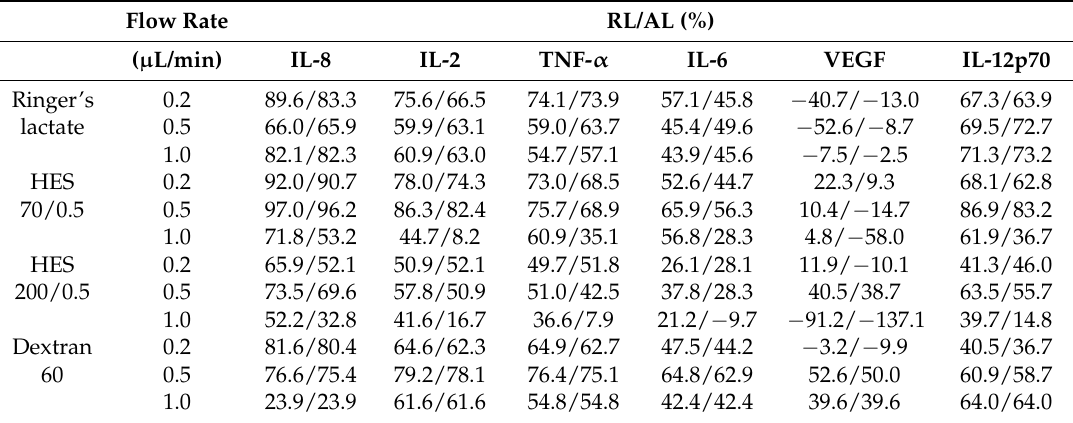
Table 2. Relative loss (left column) and Absolute loss (right column) from retrodialysis in anaesthetised domestic pigs in vivo (pooled data from two pigs). Crystalloid and colloid perfusates were used for the recovery of six cytokines at flow rates of 0.2, 0.5, and 1.0 µ L/min. Flow Rate RL/AL (%) ( µ L/min) IL-8 IL-2 TNF- α IL-6 VEGF